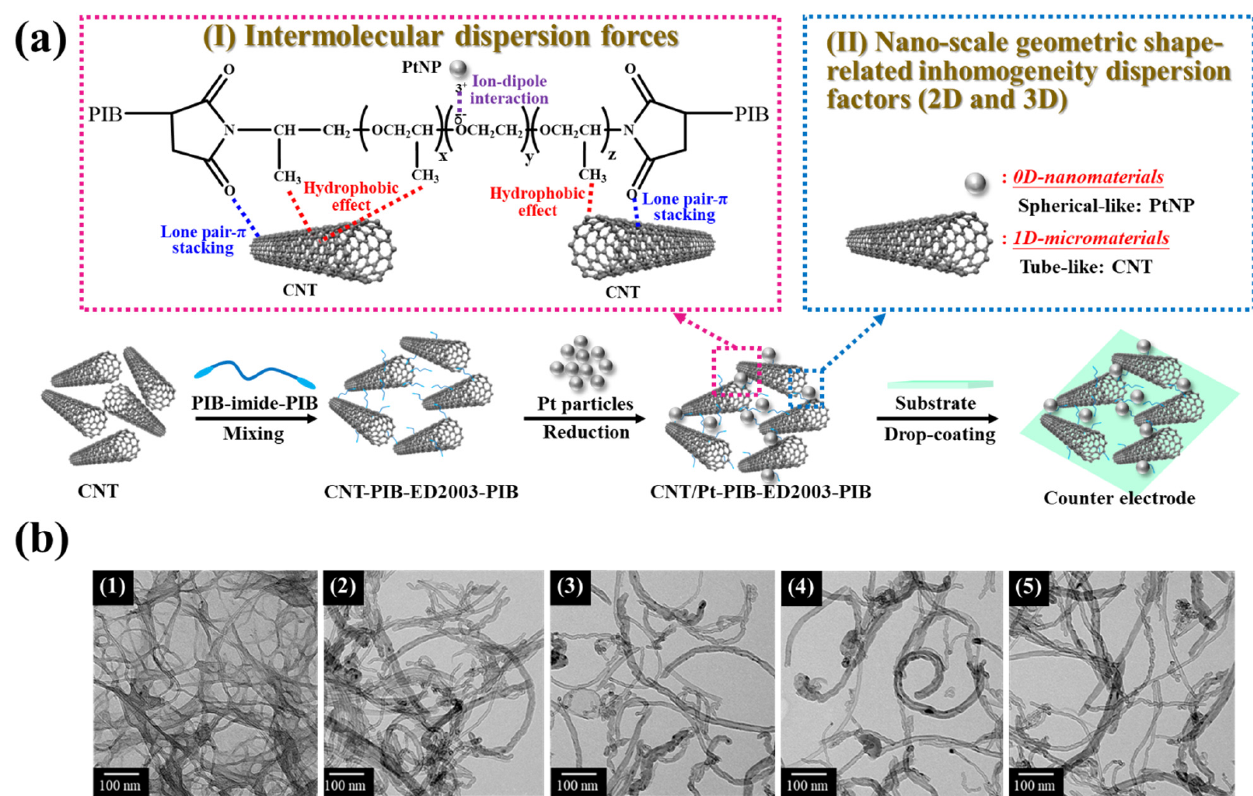
Figure 1. ( a ) Schematic of intermolecular forces between the polymer-assisted dispersant PIB-ED2003-PIB and CNTs and PtNPs. ( b ) TEM diagrams of (1) without dispersant, (2) PIB-M1000, (3) PIB-ED900-PIB, (4) PIB-ED2003-PIB, and (5) PIB-D2000-PIB added at a ratio of 2:1, 1:1, 1:2, and 1:2 to carbon nanotubes.